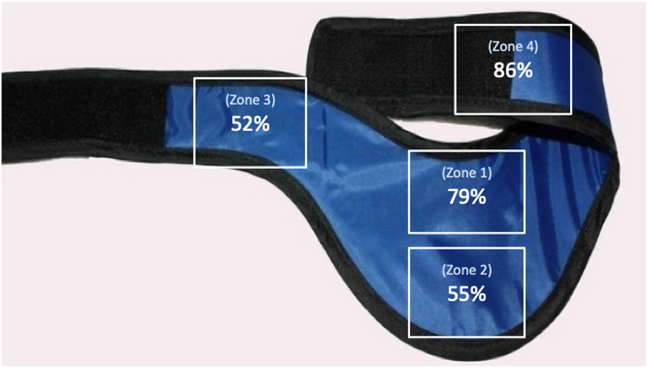
Percentage of thyroid shield contamination by quadrant.